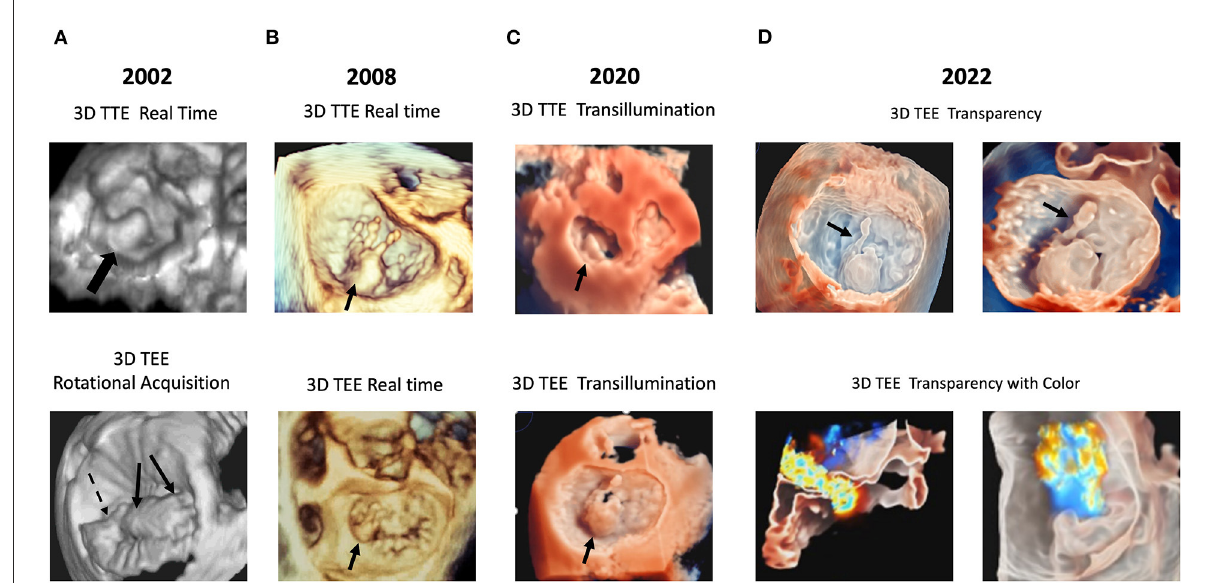
FIGURE1 Examples of technical evolution of 3D echocardiography. In (A) examples are reported of P2 prolapse by RT 3D TTE (top panel); anterior and posterior leaflet prolapse (arrows) by rotational 3D TEE (bottom panel). In (B) examples are reported of P2 flail by RT 3D TTE (top panel), and P1 flail by 3D RT TEE (bottom panel). In (C) an example is reported of TI rendering: P2 prolapse by 3D TTE (top panel) and by 3D TEE (bottom panel). In (D) an example is reported of the “transparency” effect: P2 flail with a detailed visualization of the ruptured chorda by 3D TTE (top panel); mitral regurgitation color Doppler superimposed to the 3D TEE image (bottom panel). 3D, three-dimensional; RT, real-time. TEE, transesophageal echocardiography; TI, transillumination. TTE, transthoracic echocardiography.